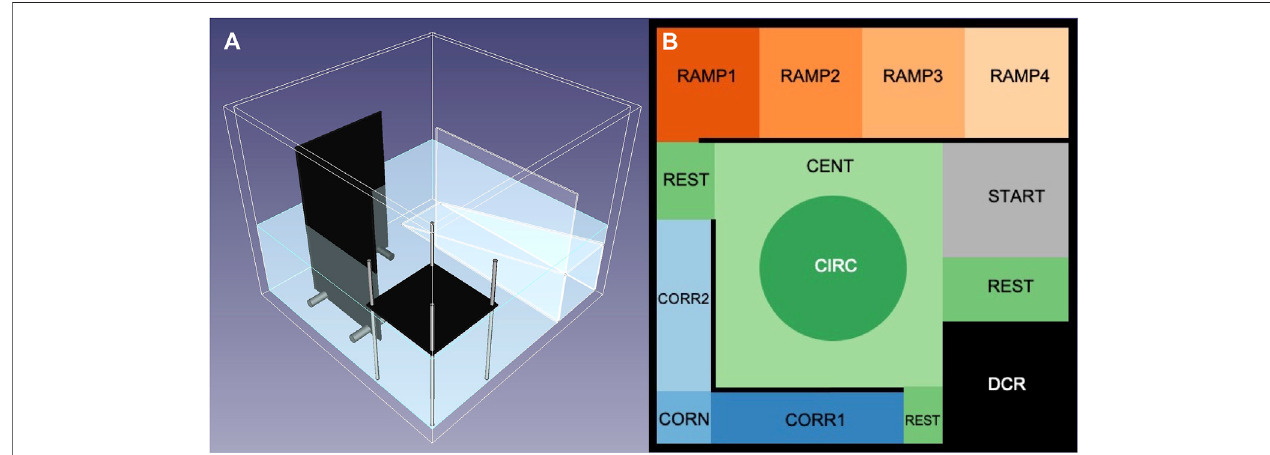
FIGURE1| ThezMCSFtestingarena,whichcontainsadarkcorner roof(DCR),twowallsbuildingacorridorand corner(CORR1,CORN,CORR2),andaninclined ramp creating decreasing water depth (RAMP1-4), all of which surround a central open area (CENT and CIRC). For exact measurements, see blueprints provided in (Vossenetal.,2022). (A) 3DmodelofthezMCSFarena. (B) Virtualdivisionofzonesinthearena,asseenbytheceilingmountedcameraandusedforvideotrackingwith Ethovision XT15 (Noldus, Wageningen, the Netherlands). Images reprinted from (Vossen et al., 2022). Abbreviations: CENT, center; CIRC, central circle; CORN, corner; CORR, corridor; DCR, dark corner roof; REST, the part of the arena not designated to any other zone.